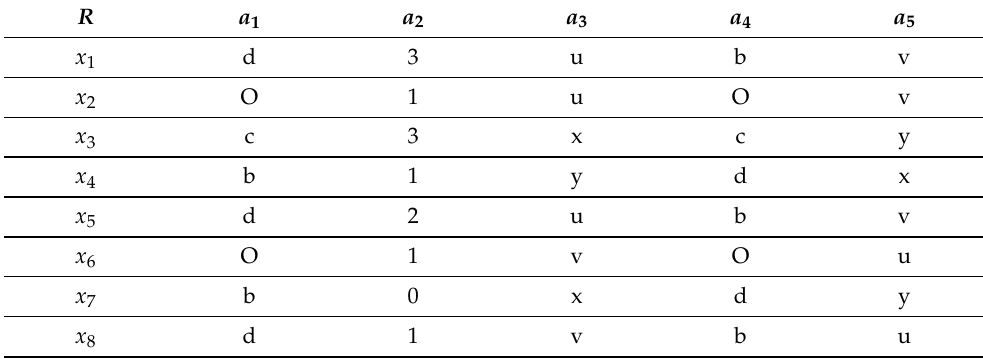
Table 3. Relation of formal context ( P , O , L , R ) .